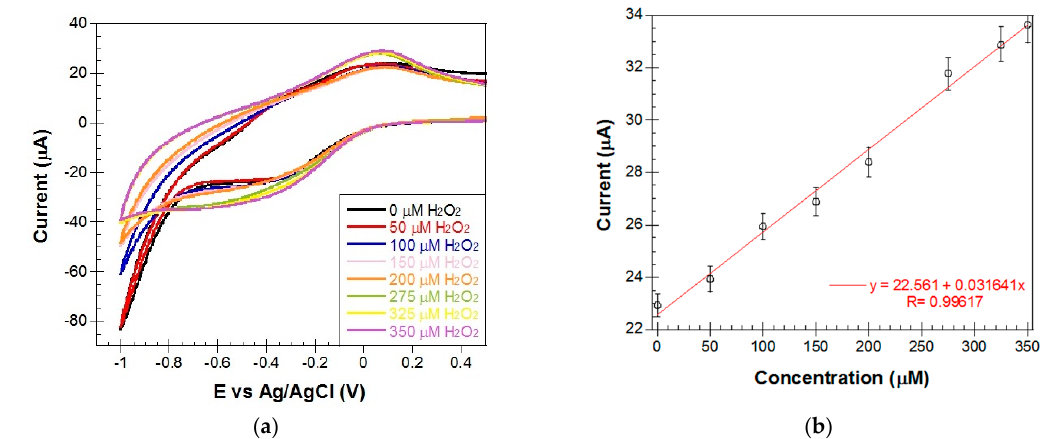
Figure 12. ( a ) CVs obtained for a Metglas/ZnO/Hb electrode in PBS buffer before and after the